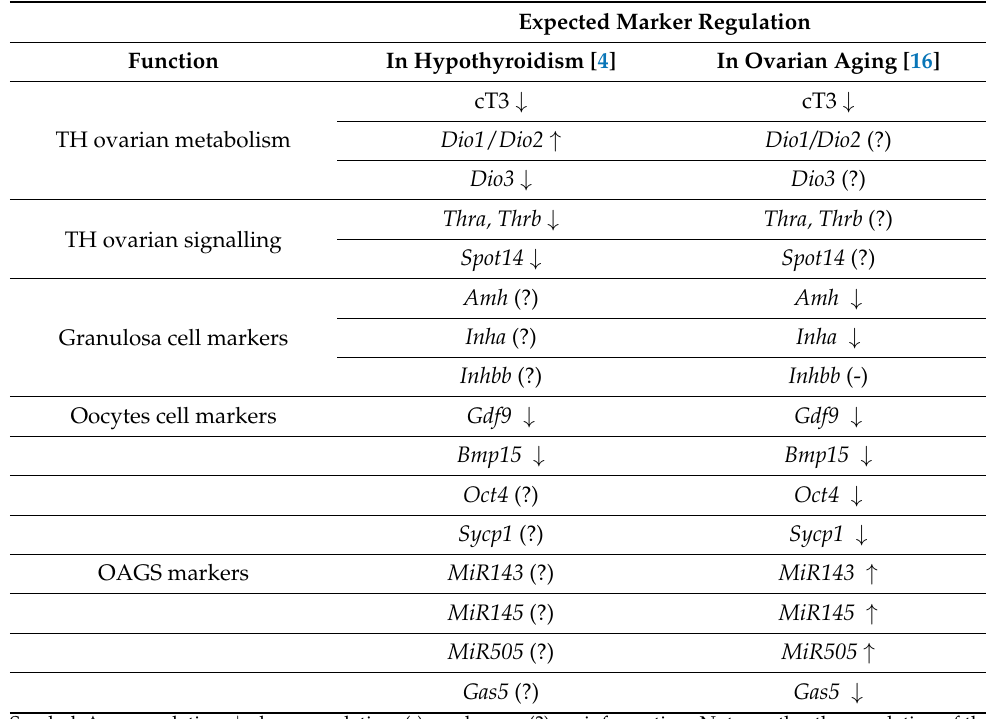
Table 1. Schematic representation of the marker of tissue thyroid hormone status and ovarian health in hypothyroidism and premature ovarian